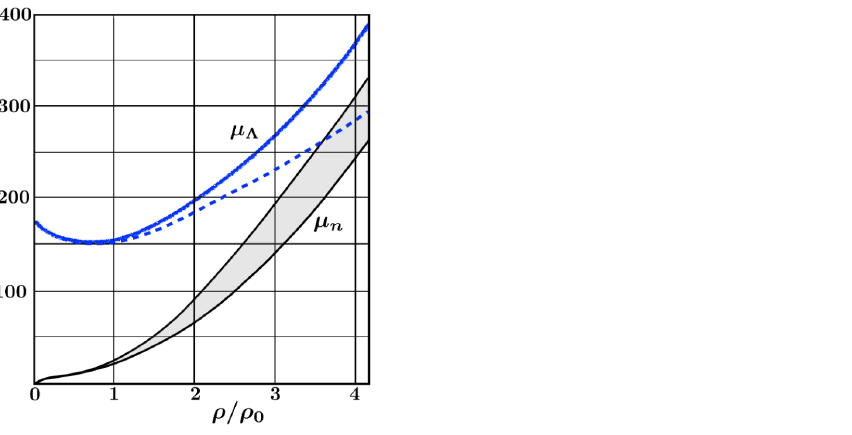
Figure 4. Chemical potentials of Λ hyperon µ Λ and neutron µ n in neutron matter versus baryon density (in units of saturation density). The neutron chemical potential (grey shaded area) is based on a chiral FRG calculation. The blue dashed line indicates the Λ chemical potential calculated with Λ N interactions only, whereas the blue solid line refers to a calculation taking into account both Λ N and Λ NN interactions [21].